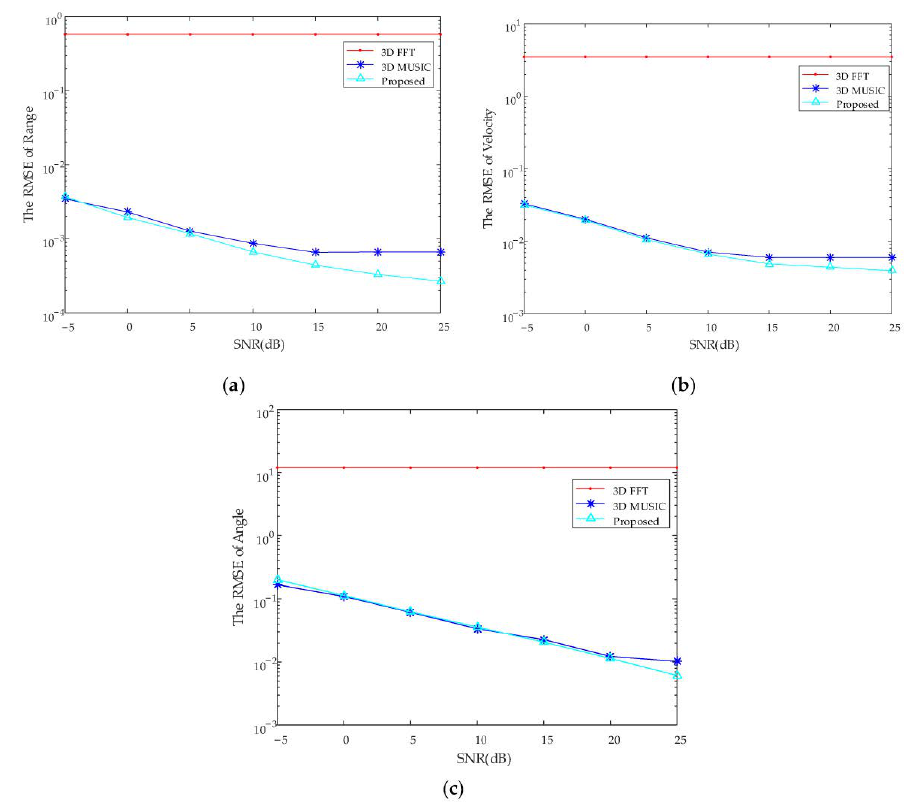
Figure 8. The results of accuracy comparison. ( a ) the RMSE of range. ( b ) the RMSE of velocity. ( c ) the RMSE of